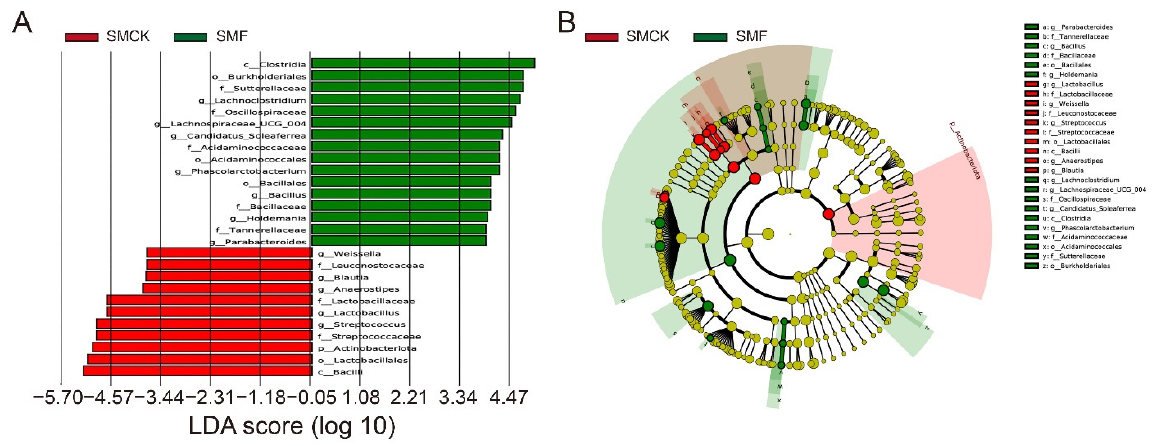
Figure 4. Comparisons of difference microorganisms between the SMCK and SMF groups using LEfSe. ( A ) Linear discriminant analysis (LDA) score, ( B ) LEfSe evolutionary branch graph. The diameter of the node was proportional to the relative abundance. The node in each layer represented the phylum/class/order/family/genus from the inside to the outside, and the annotations of the species labels were opposite; different letters corresponded to different species.